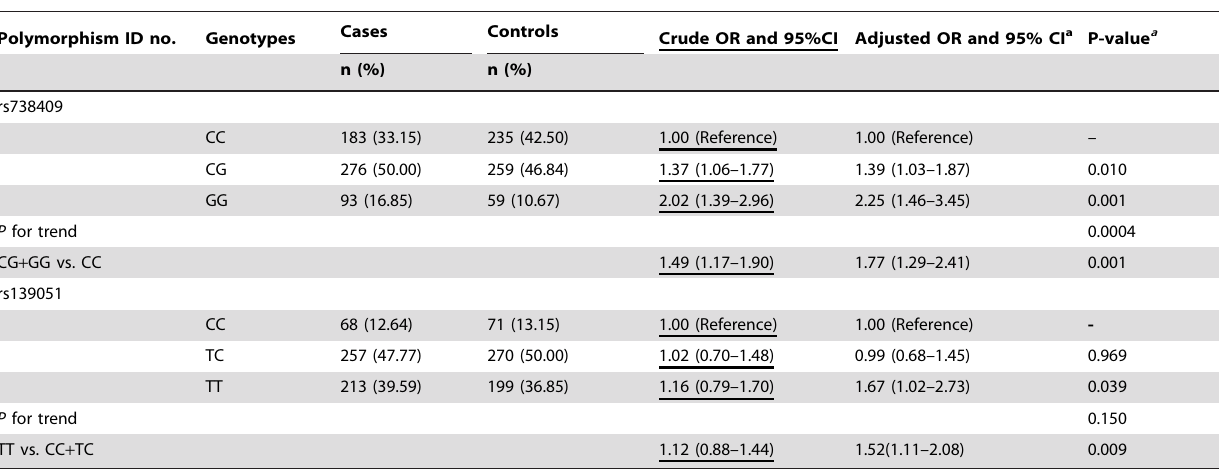
Table 1. Association between the genotypes of rs738409 and rs139051 and risk of NAFLD.